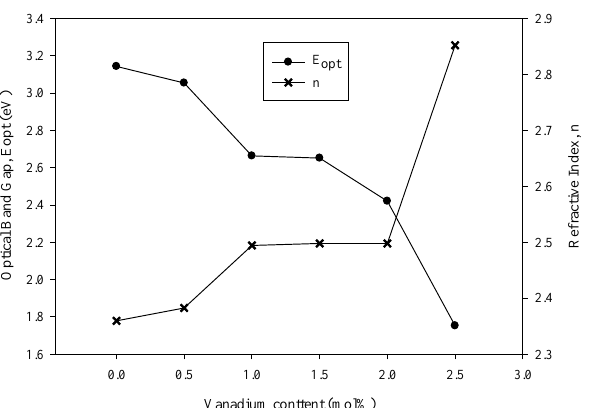
Figure 8. Optical band gap (E opt ) and refractive index of (59.5– x ) B 2 O 3 –20Na 2 O–20CaO – x V 2 O 5 – Er 2 O 3 –0.5AgCl ( x = 0, 0.5, 1.0, 1.5, 2.0 and 2.5 mol%). The E U values of the glass increased sharply from 0.298 eV to 0.482 eV ( x = 0 mol%– 0.5 mol%), followed by a sharp decrease when 1.0 mol%–1.5 mol% of vanadium was added into the glass samples. The E U values gradually increased to 0.762 ( x = 2.5 mol%) with further increase in V 2 O 5 content (Figure 9). The addition of vanadium x = 0.5 mol% increased the Urbach energy value, and this effect indicated the increased tendency of weak bonds to become defects. For x = 0.5 mol%, the concentration of the defect increased in the glass network with the increment of NBO. The Urbach energy value decreased for x = 1.0 and 1.5 mol%. This decrement suggested that the degree of disorder present in the glass decreased. However, for x > 1.5 mol%, the increase in Urbach energy reduced the energy band gap, whereas the decrease in Urbach energy increased the energy band gap.